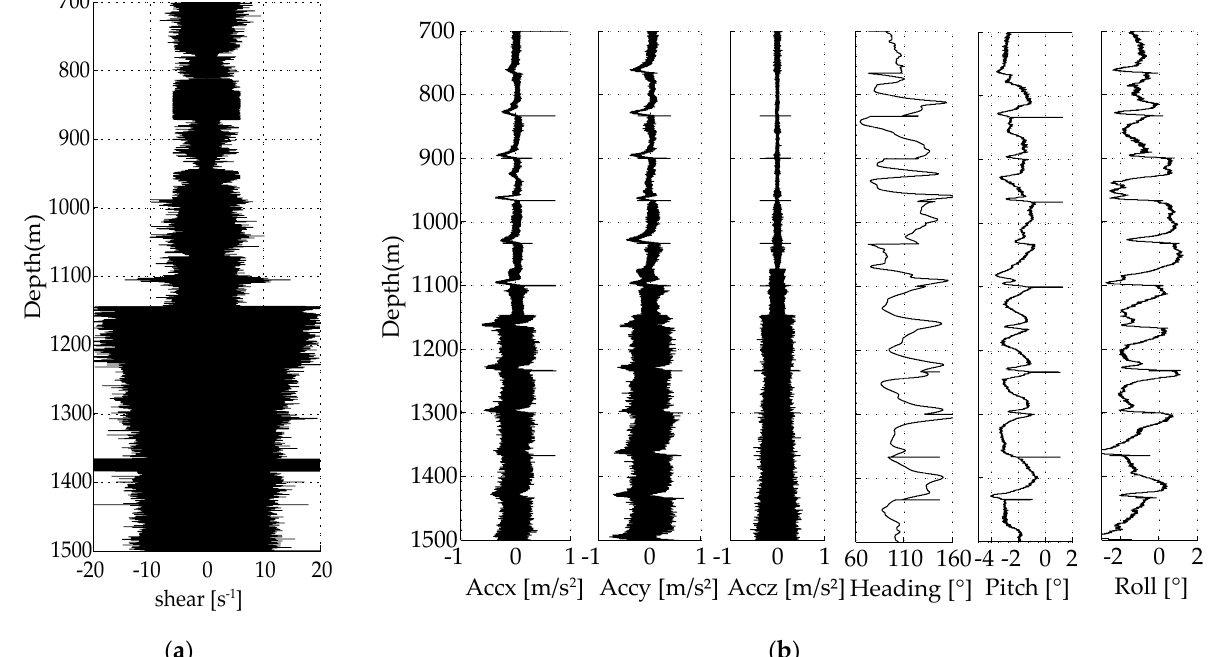
Figure 5. Time series of the collected shear and accelerometer data from three-axis vibration sensors.